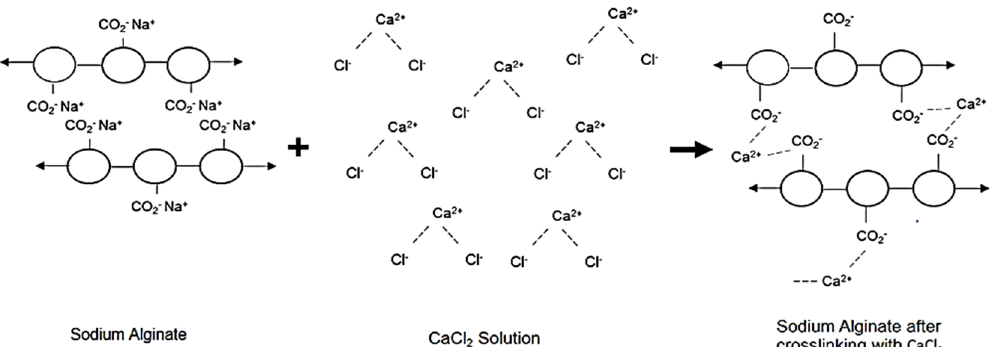
Figure 1. Sodium alginate gelation through crosslinking by exchange of sodium ions (Na + ) and calcium ions (Ca 2+ ).